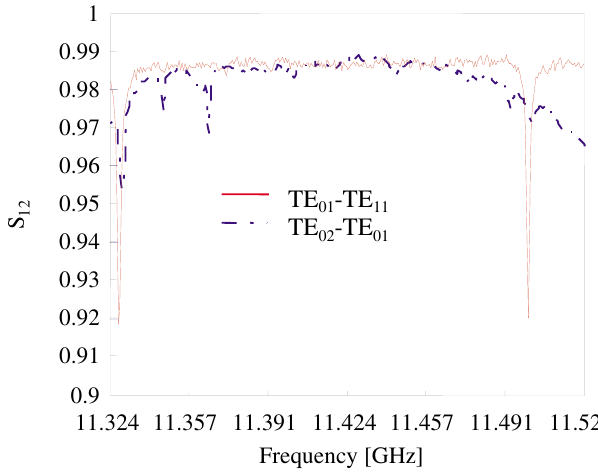
FIG. 4. (Color) Measured S mode and the circular TE and the circular TE response of mode transducers necessary to launch the mode at each end of the taper.